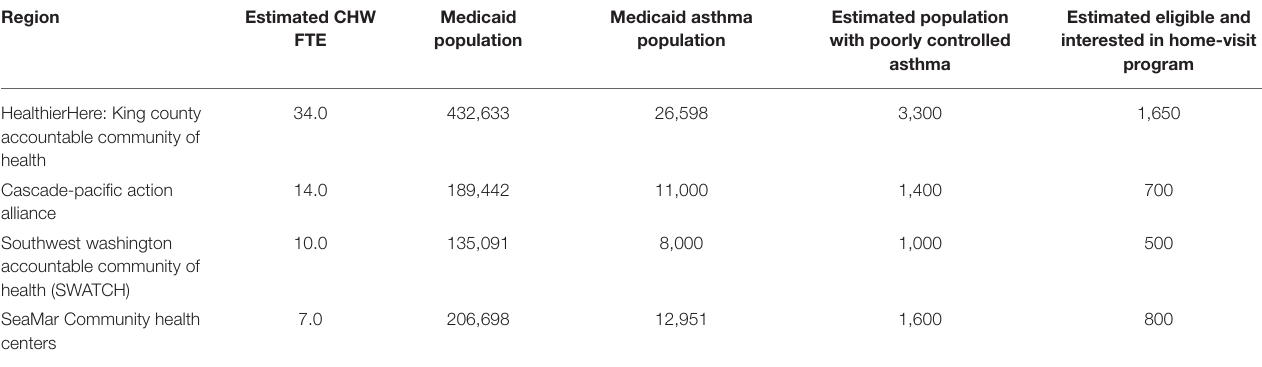
TABLE 1 | Community characteristics. Region Estimated CHW